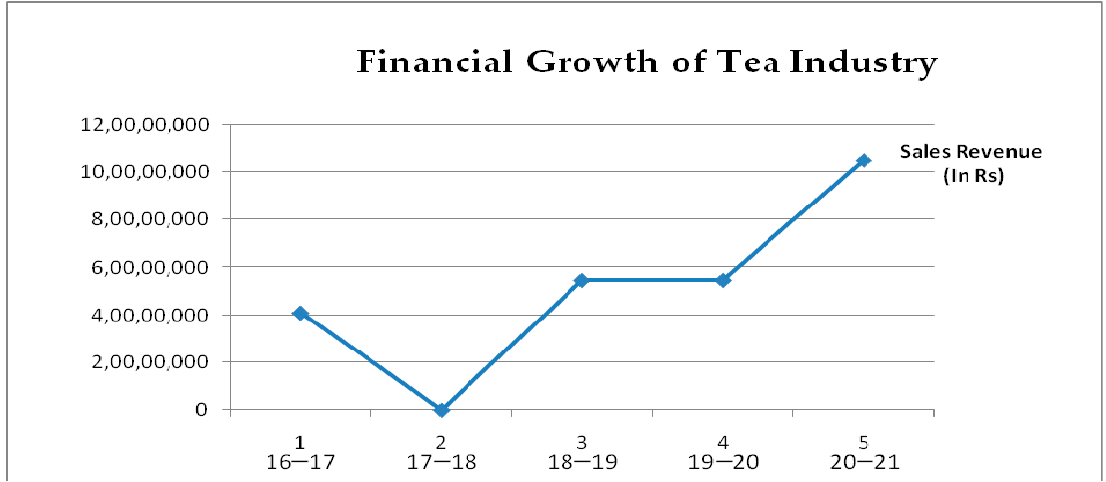
Figure 5. Graph showing steady rise in sales revenue from 2016 to 2021(in INR).